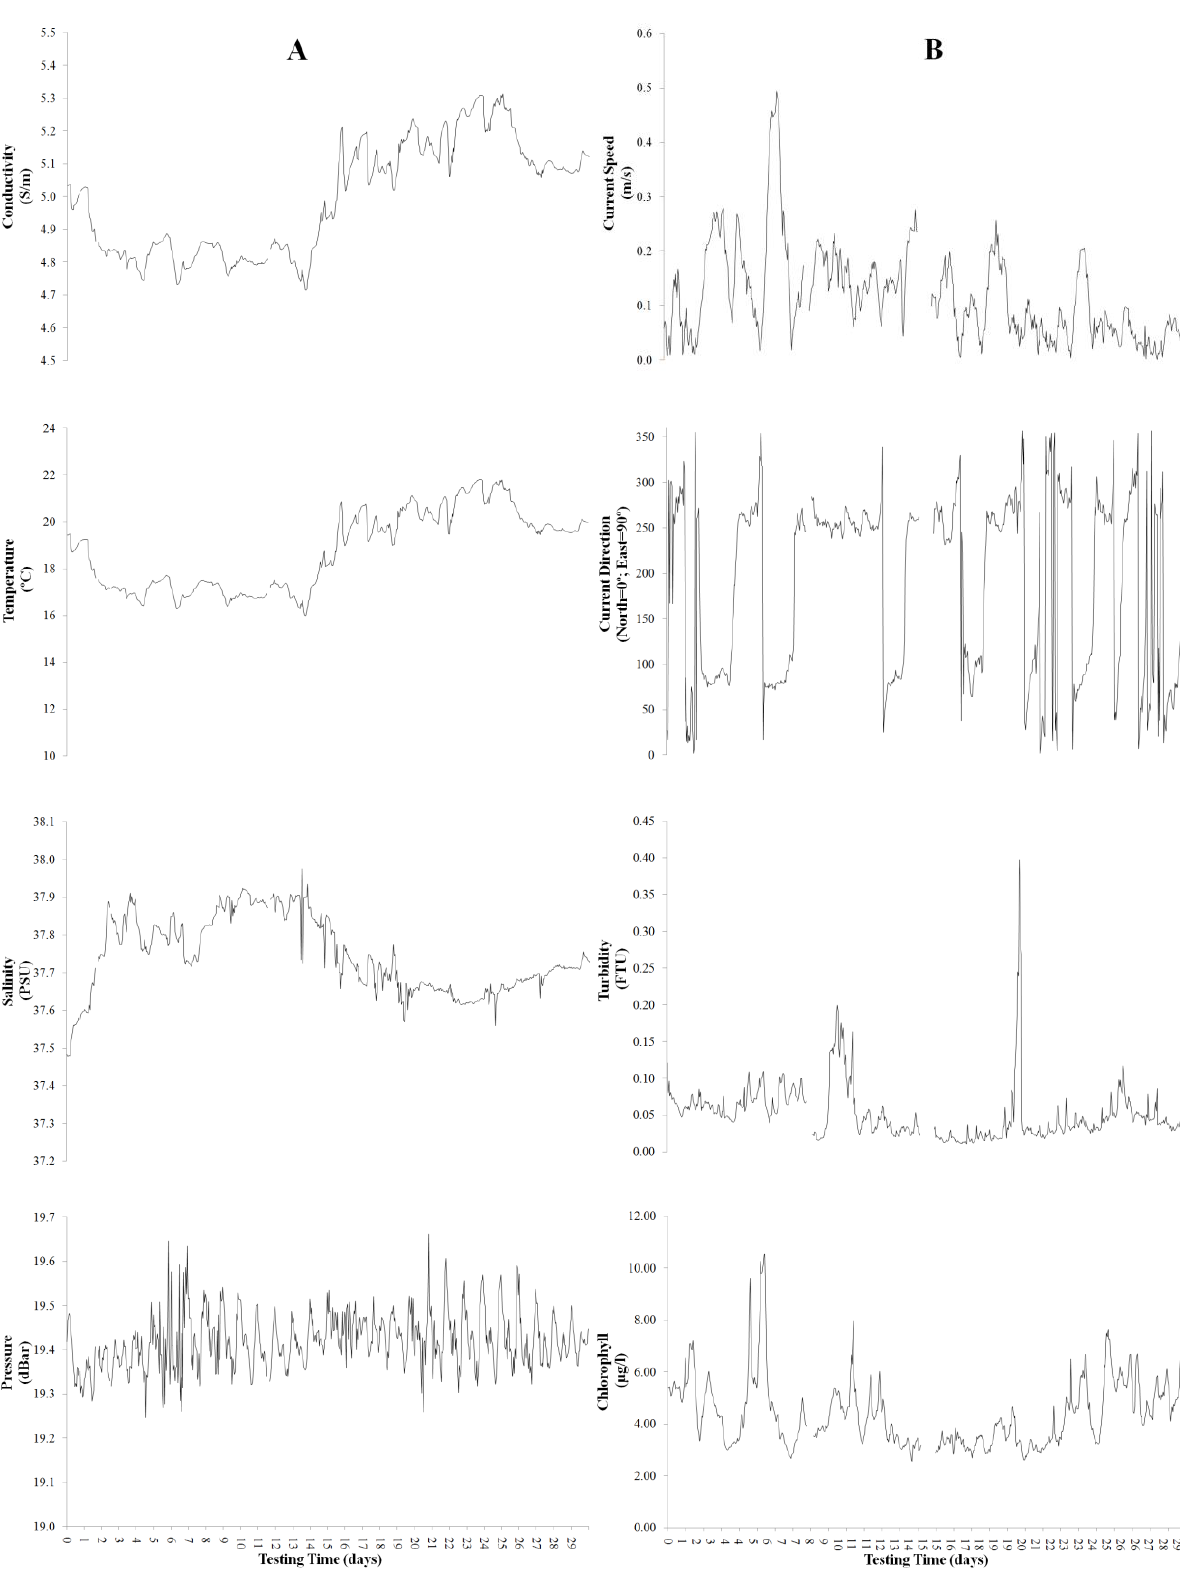
Figure 4. One-month time series of processed hourly oceanographic data, as recorded by CTD (A) and ADCP (B) sensors installed on the OBSEA seafloor cabled observatory